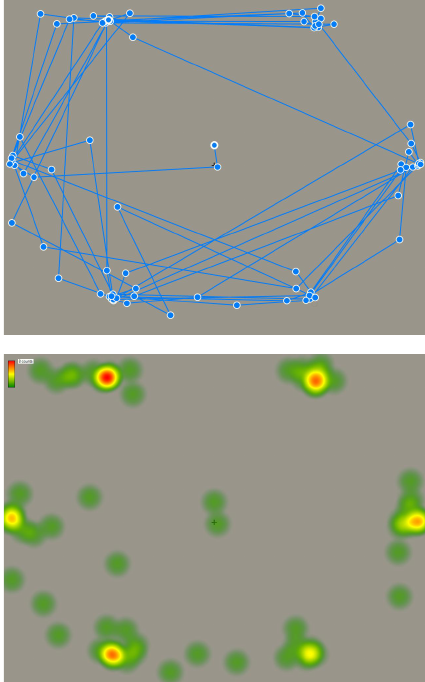
Figure 2. Reduced contrast and increased distance between the letters improved the data quality, by forcing the participants to look at the letters directly without using their peripheral vision. A sample gaze trajectory (Top) and the heat map of fixations (Bottom) are